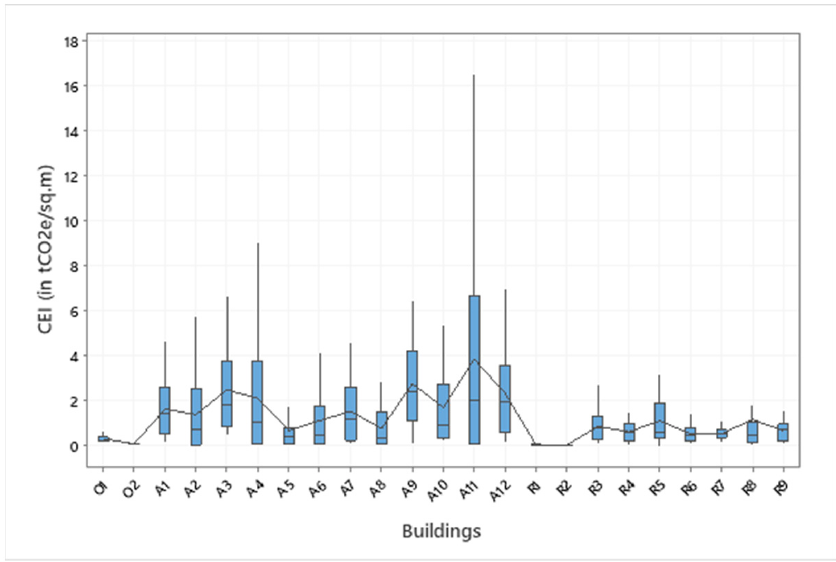
Figure 8. Box-plot of the calculated CUI in the university.